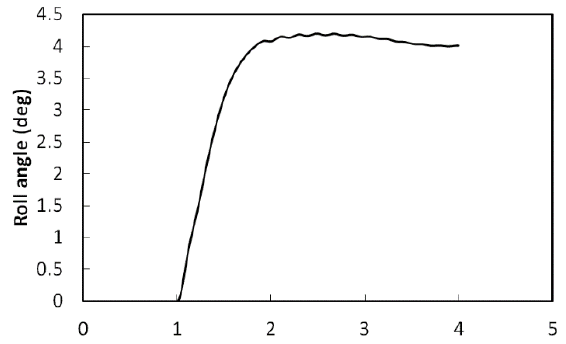
Figure 15. The roll angle without control.